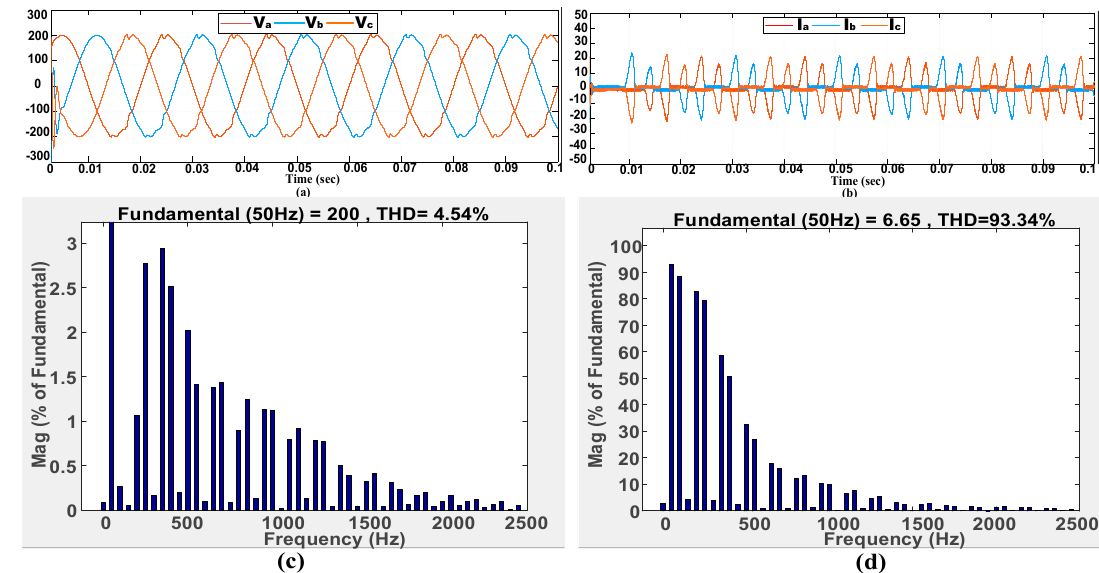
Figure 10. Simulation results with the DB predictive controller in steady-state condition. ( a ) Output voltage, ( b ) Load current, ( c ) THD value of voltage, ( d ) THD values of current.